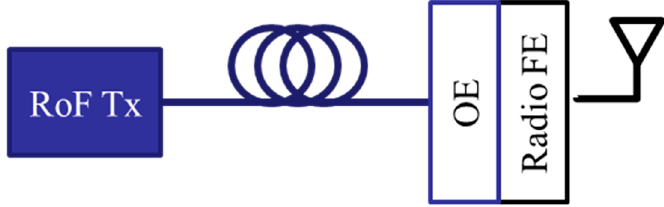
Figure 3. Configuration of RoF optical-to-radio interface for radio-wave radiation.